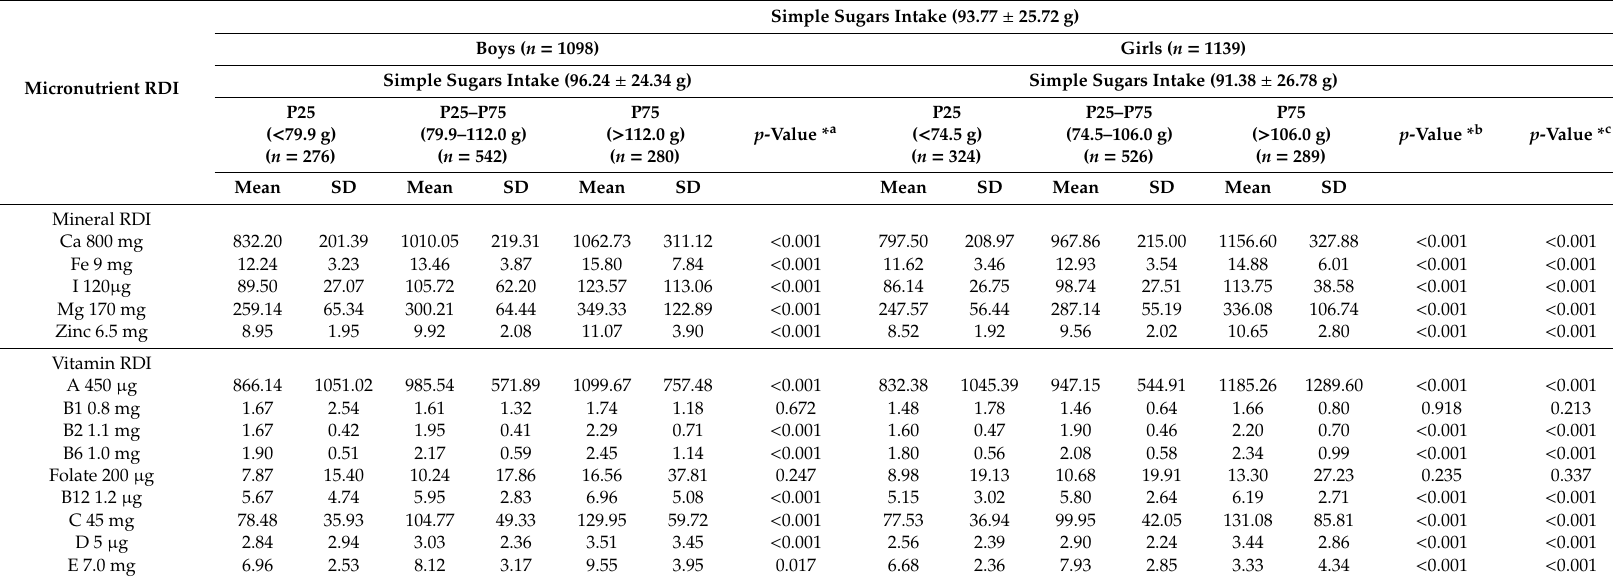
Table 10. Micronutrients intake consumed by 6–8 years old children ( n = 2237) in Valencia, Spain,